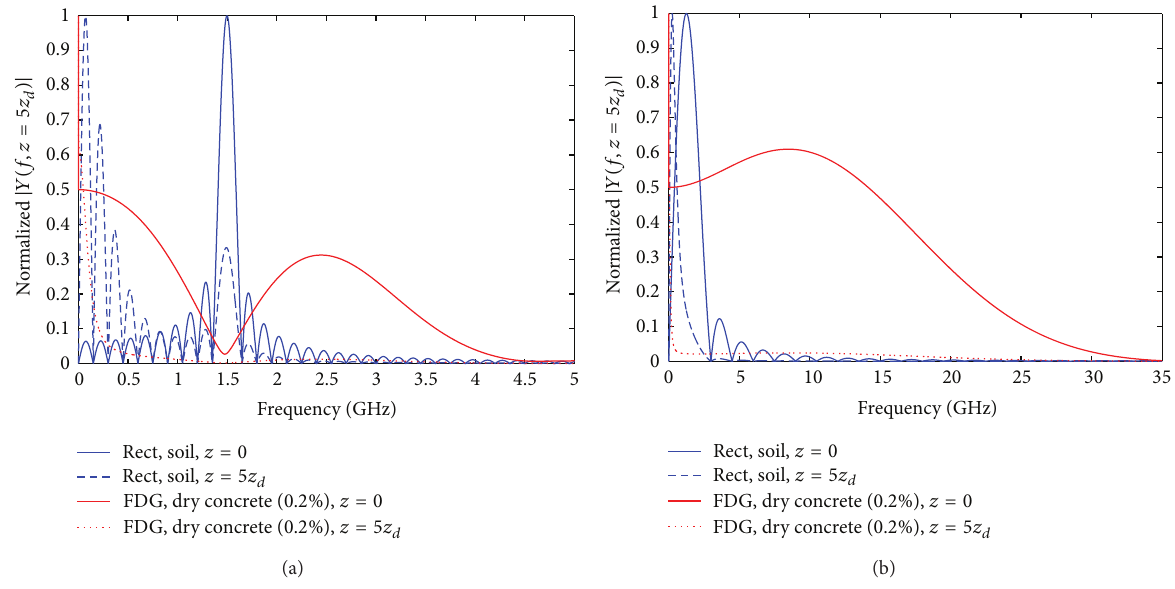
Figure 11: Frequency spectra for rectangular and FDG pulses after propagating through 𝑧 = 4⋅𝑧 𝑑 through soil and concrete at 𝑓 0 = 1.5 GHz, with pulse duration (a) 𝑇 𝑏 = 10/𝑓 0 and (b) 𝑇 𝑏 = 1/𝑓 0 .